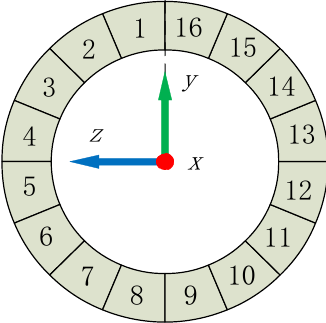
Figure 9. Number of adjusting plates outside the